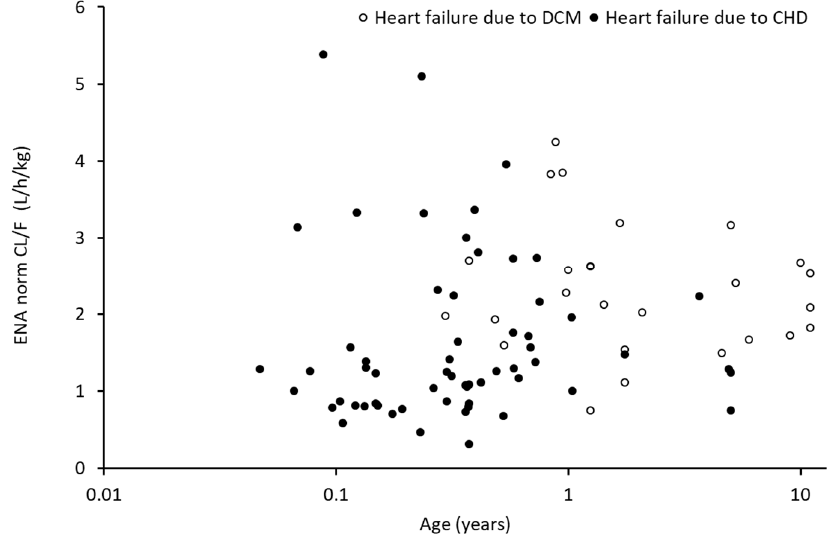
Figure 2. Body weight normalized apparent oral clearance of Enalapril as function of age in patients with heart failure due to dilated cardiomyopathy (open circles, n = 25) and due to congenital heart disease (closed circle, n = 61).